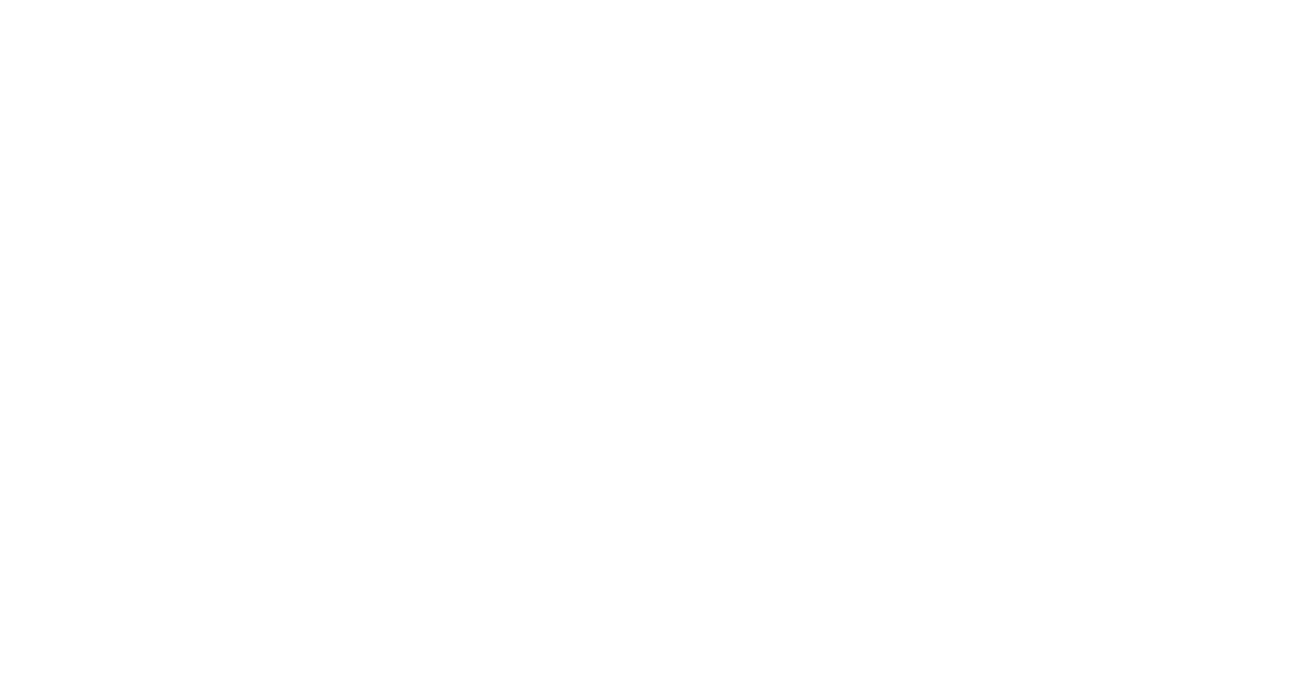
FIGUREA8 | Monocyte-derived DCs (moDCs) and B cells from human blood take up and process a long peptide consisting of the first 35 amino acids of the E7 oncoprotein, MHGDTPTLHEYMLDLQPETTDLY CYEQLNDSSEEE. Both the E7 11–19 and E7 11–20 peptides are cross-presented as surface HLA-A ∗ 02 complexes with the E7 11–20 peptide more abundant. (A) Poisson detection plot of the MS 3 555.3/764.4 spectrum (for E7 11–19 ) of peptides recovered from moDCs loaded with 35-mer; (B) Poisson detection